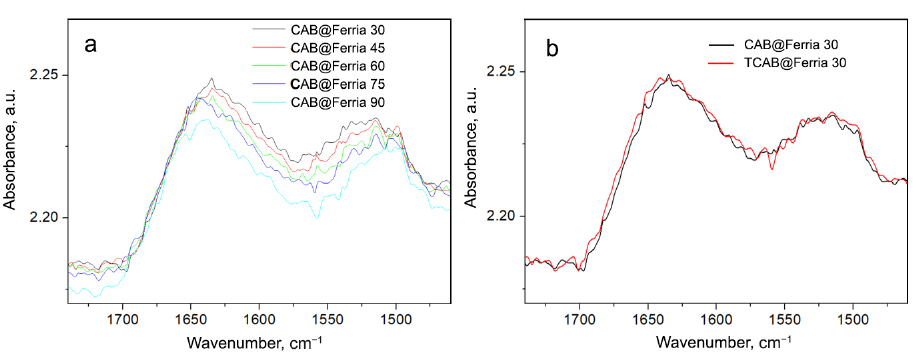
Figure 8. ( a ) Spectra of CAB@Ferria recorded at different temperatures (from 30 to 90 ◦ C with a step of 15 ◦ C) in the region of Amide I and II vibrations. ( b ) Spectrum of CAB@Ferria recorded at 30 ◦ C (black curve); spectrum of CAB obtained at 30 ◦ C after cooling from 90 ◦ C (red